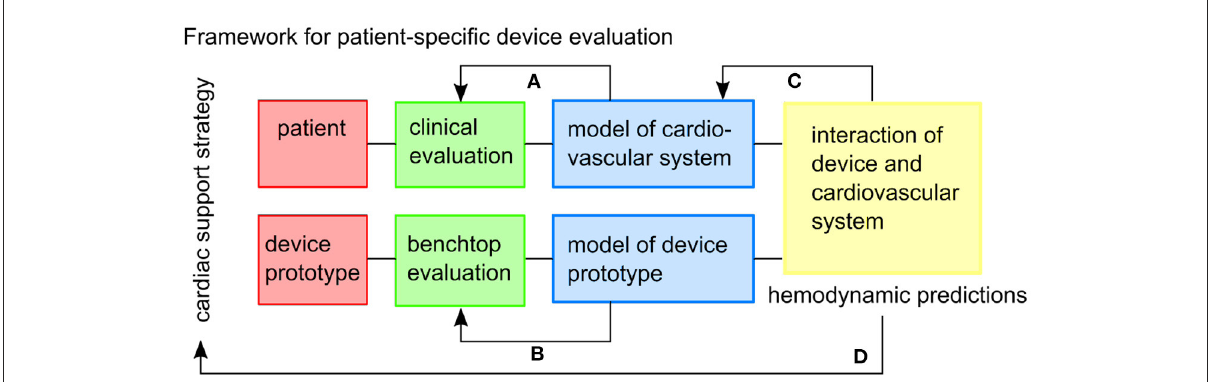
FIGURE1 The framework envisioned for patient-specific testing of cardiac support strategies. Feedback within the framework includes: (A) the patient-specific cardiovascular model is tuned to the clinical data, (B) the model of the device prototype is informed by benchtop experiments, (C) the combined model might inform additional physiological mechanisms to be included in the cardiovascular model, (D) and hemodynamic predictions can inform the usefulness of the cardiac support strategy in the specific patient cohort.